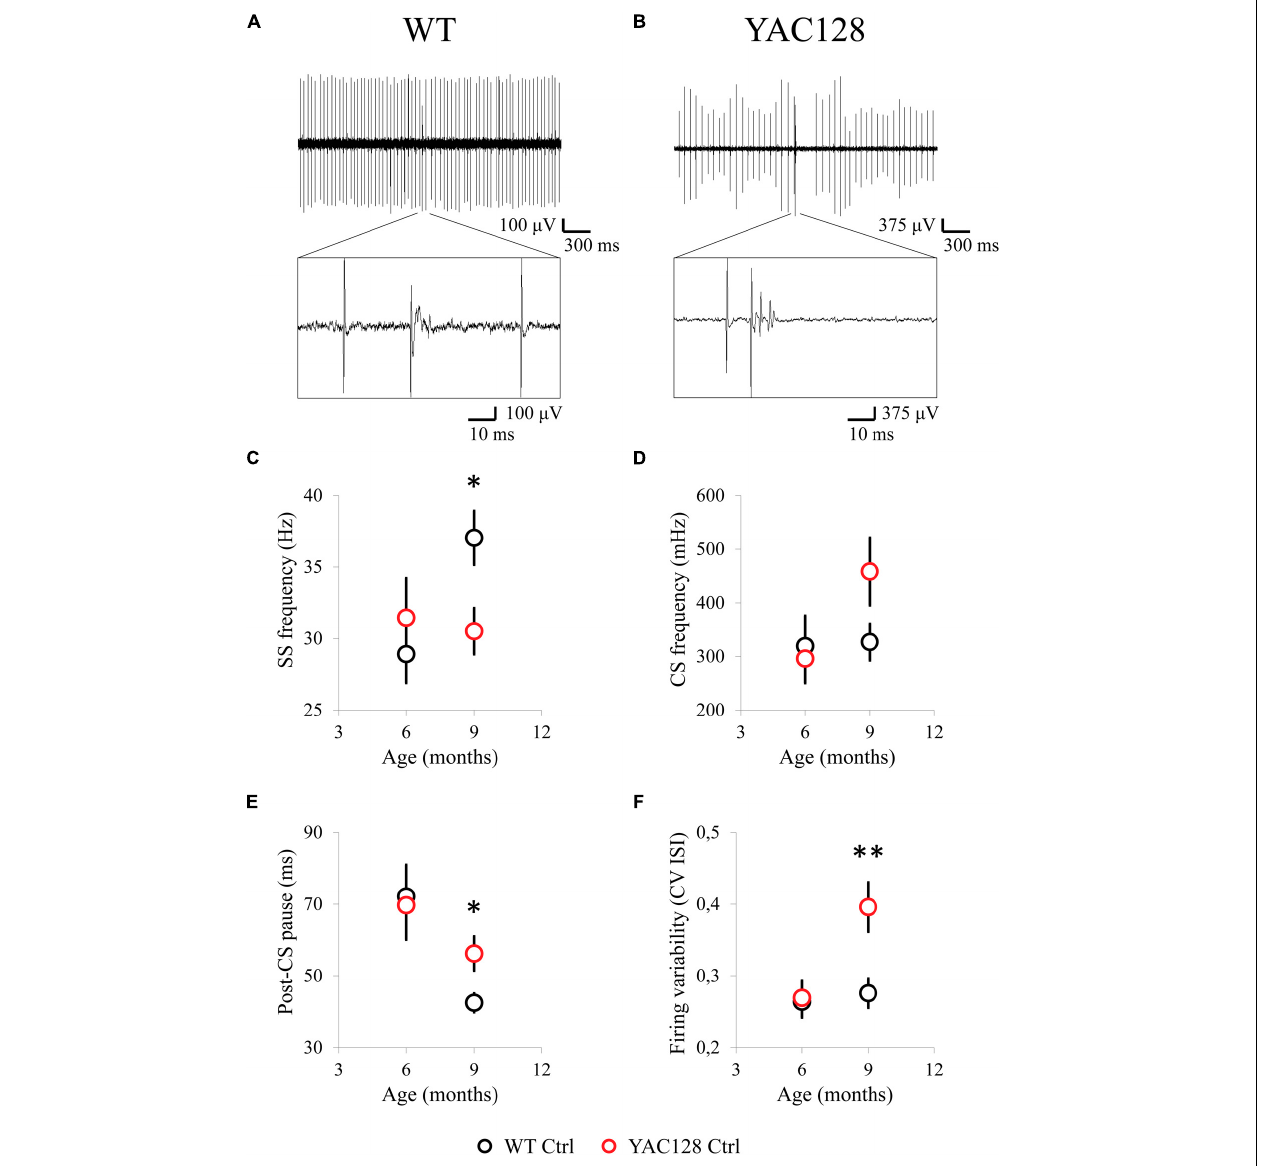
FIGURE 1 | Spontaneous activity of cerebellar PCs in 6- and 9-month-old WT and YAC128 HD mice. (A,B) Examples of PC firing activity in 9-month-old WT (A) and YAC128 (B) mice. Recording traces are 3 s in duration with enlarged 100-ms fragment containing CS is shown. (C) The average SS firing frequency of PCs for 6- and 9-month-old WT ( n = 23 and 34 cells; m = 10 and 7 mice) and YAC128 mice ( n = 24 and 31 cells; m = 6 and 7 mice) is shown as mean ± SE. * p < 0.05. (D) The average CS firing frequency of PCs for 6- and 9-month-old WT ( n = 23 and 34 cells; m = 10 and 7 mice) and YAC128 mice ( n = 24 and 31 cells; m = 6 and 7 mice) is shown as mean ± SE. No statistically significant difference was observed. (E) The average post-CS pause in PC discharge for 6- and 9-month-old WT ( n = 23 and 34 cells; m = 10 and 7 mice) and YAC128 mice ( n = 24 and 31 cells; m = 6 and 7 mice) is shown as mean ± SE. * p < 0.05. (F) The CV ISI of tonically firing PCs was analyzed. Tonically firing PCs in 9-month-old HD mice fired more irregularly. ** p < 0.01.